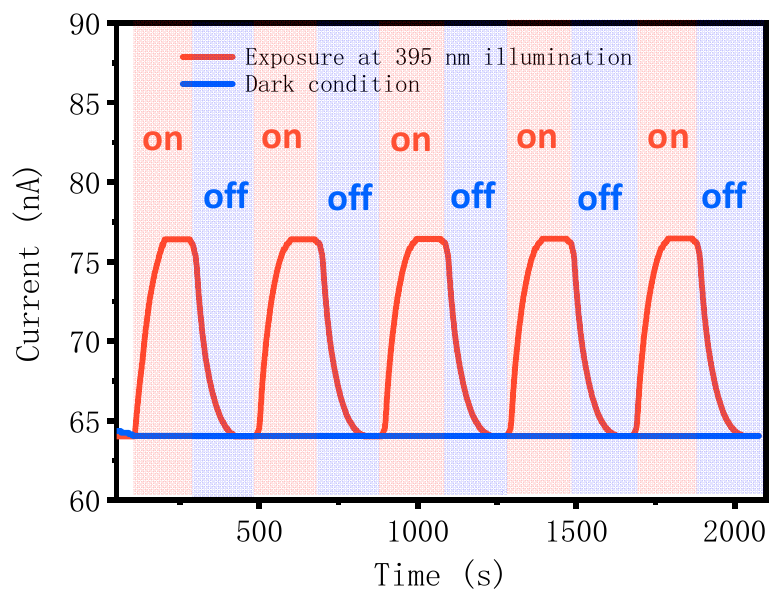
Figure 6. PGO vertical p–n junction photoelectric response.